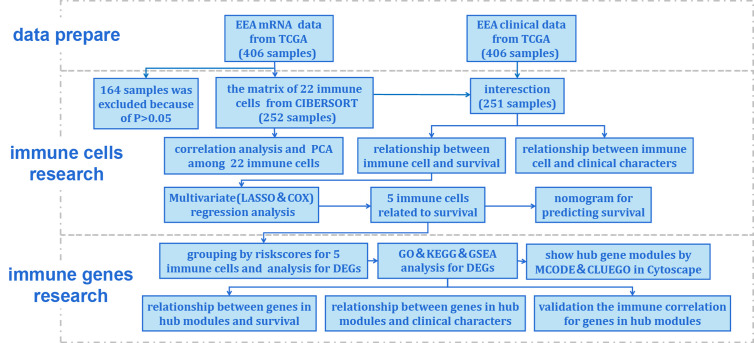
Flow chart of the data processing procedures. UCEC, uterine corpus endometrial carcinoma. TCGA, the Cancer Genome Atlas (https://portal.gdc.cancer.gov/). CIBERSORT, a method for analysis immune cells composition of complex tissues from their gene expression profiles (http://cibersort.stanford.edu/); PCA, principal component analysis; LASSO, least absolute shrinkage and selector operation regression analysis; COX, Cox proportional hazards regression analysis; DEGs, differentially expressed genes; GO, Gene Ontology; KEGG, Kyoto Encyclopedia of Genes and Genomes; GSEA, Gene Set Enrichment Analysis; MCODE, molecular complex detection plugin in Cytoscape software; CLUEGO, an app for enrichment analysis in Cytoscape software.